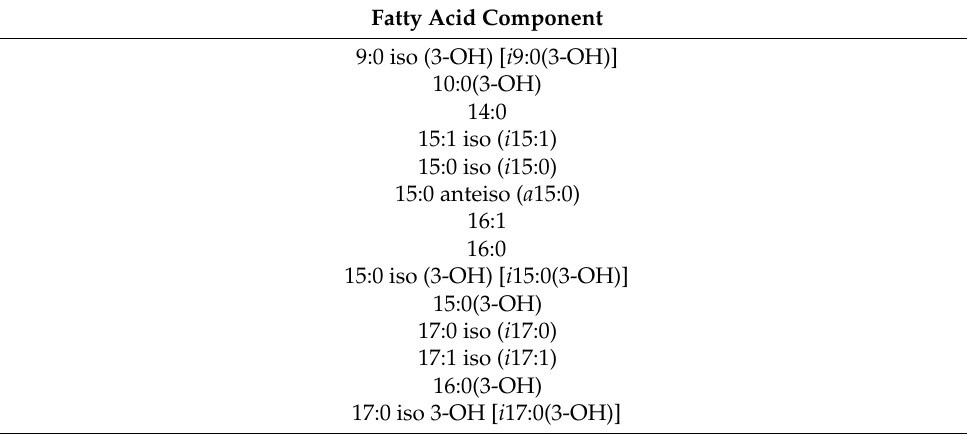
Table 1. Fatty acid content of the LPS isolated from the two Echinicola strains examined in the current study. Both strains displayed the same fatty acid composition and were both characterized by a disaccharide of D -glucosamine as the lipid A sugar backbone carrying an additional saccharidic moiety, i.e., a D -galacturonic acid. For the unsaturated acyl chains, the position of the double bond or the stereochemistry remain to be defined. Fatty Acid